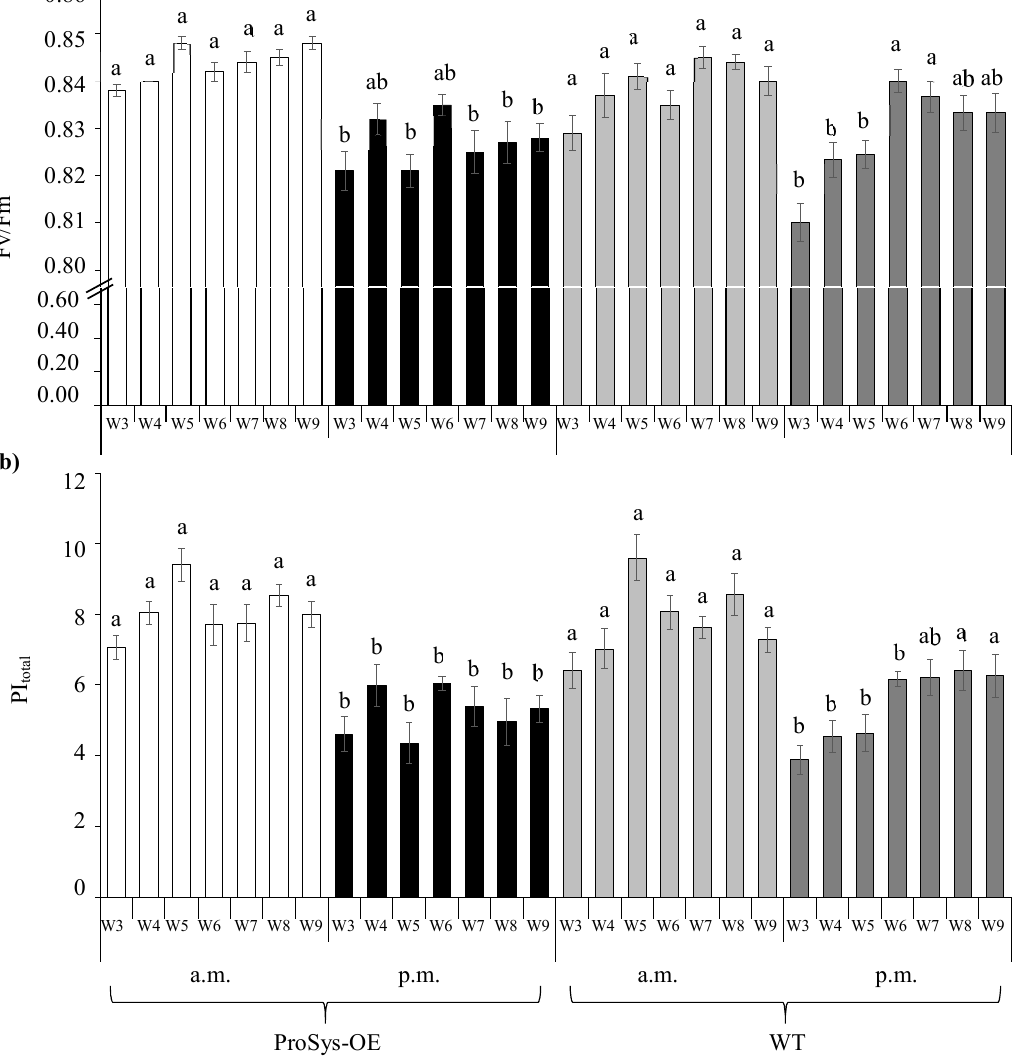
Figure 3. Photosynthetic performance of wild-type (WT) and prosystemin overexpressing (ProSys-OE) tomato plants. The measurement of ( a ) the photochemical efficiency of the PSII photosystem (determined as the Fv/Fm ratio), and ( b ) the plant photosynthetic performance, (as PI total ), was measured in wild-type (WT) untransformed tomato plants and in plants overexpressing the ProSys precursor protein of the systemin peptide hormone. WT and ProSys-OE tomato plants were monitored during a 7-week period (W3–W10) starting at week 3 (W3) after transplant. The bars represent the mean value of the measurements performed in 10 plants with three technical repetitions each. Different letters over the bars represent statistically significant differences at p < 0.05 (Tukey test). The measurements were performed in the morning (8 a.m.) and afternoon (6 p.m.) in the spring-summer of 2019 in Irapuato, Gto. M é